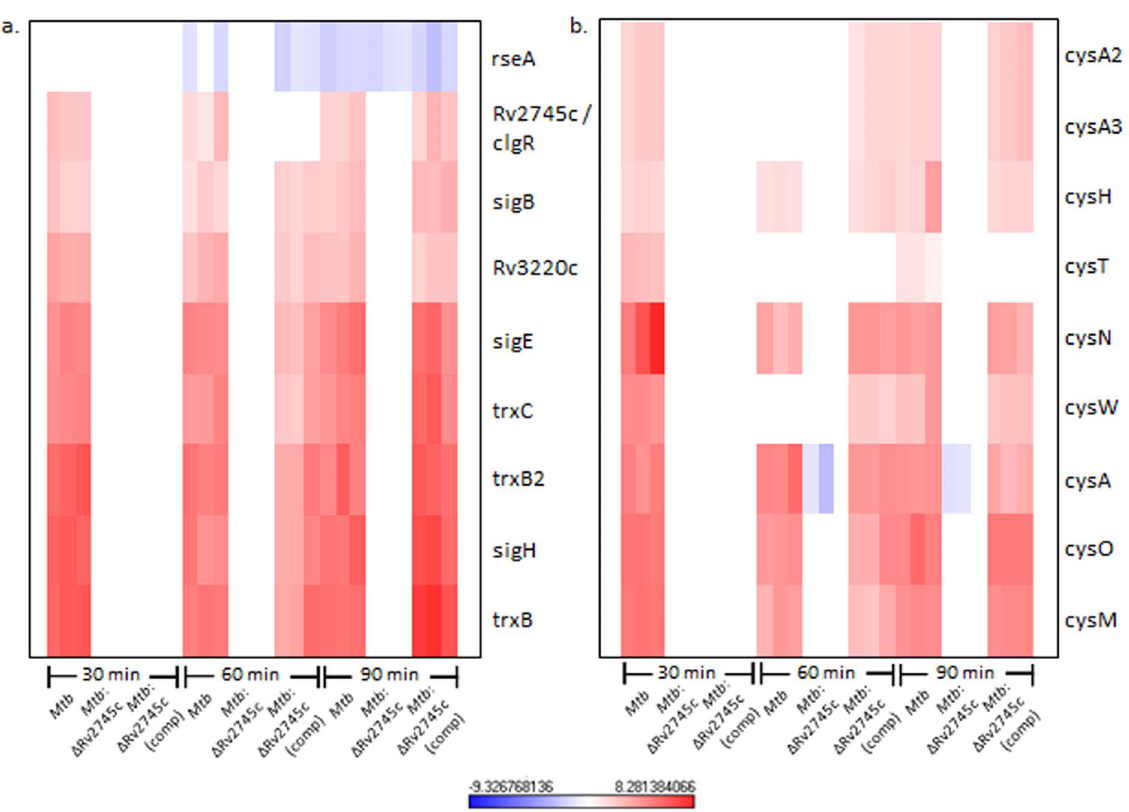
Figure 4. s H Regulon and Cysteine Pathway Induction. Heat maps show results of unsupervised hierarchical clustering focusing on the genes with the highest magnitude of change. a.) s H regulon and the b.) cysteine pathway are induced in Mtb and Mtb : D Rv2745c (comp), whereas there is no change in expression levels in the isogenic mutant indicating that Rv2745c plays a role in these regulatory networks, via direct or indirect regulation. n=3. Red color indicates induction while blue color indicates repression, relative to the control channel. The intensity of each color corresponds to the magnitude.